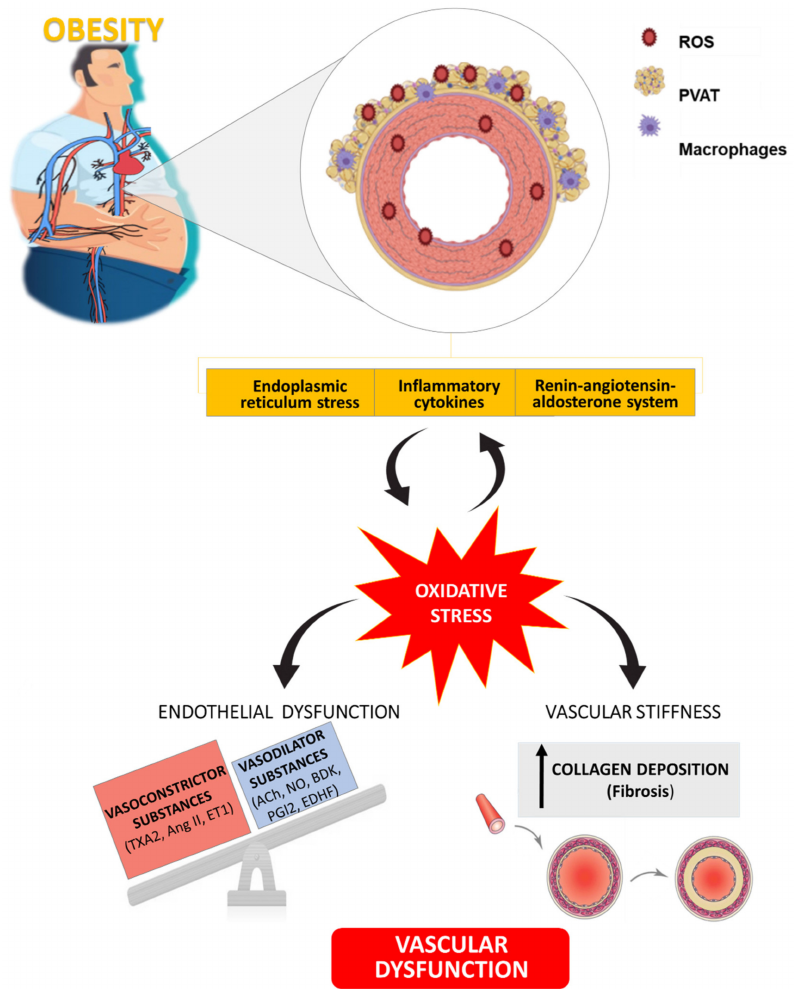
Figure 3. Schematic illustration showing the role of oxidative stress as well as its connection with dif- ferent mechanisms involved in vascular alterations associated with obesity. TXA 2 : Thromboxane A 2 ; Ang II: Angiotensin II; ET1: Endothelin 1; ACh: Acetylcholine; NO: Nitric Oxide; BDK: